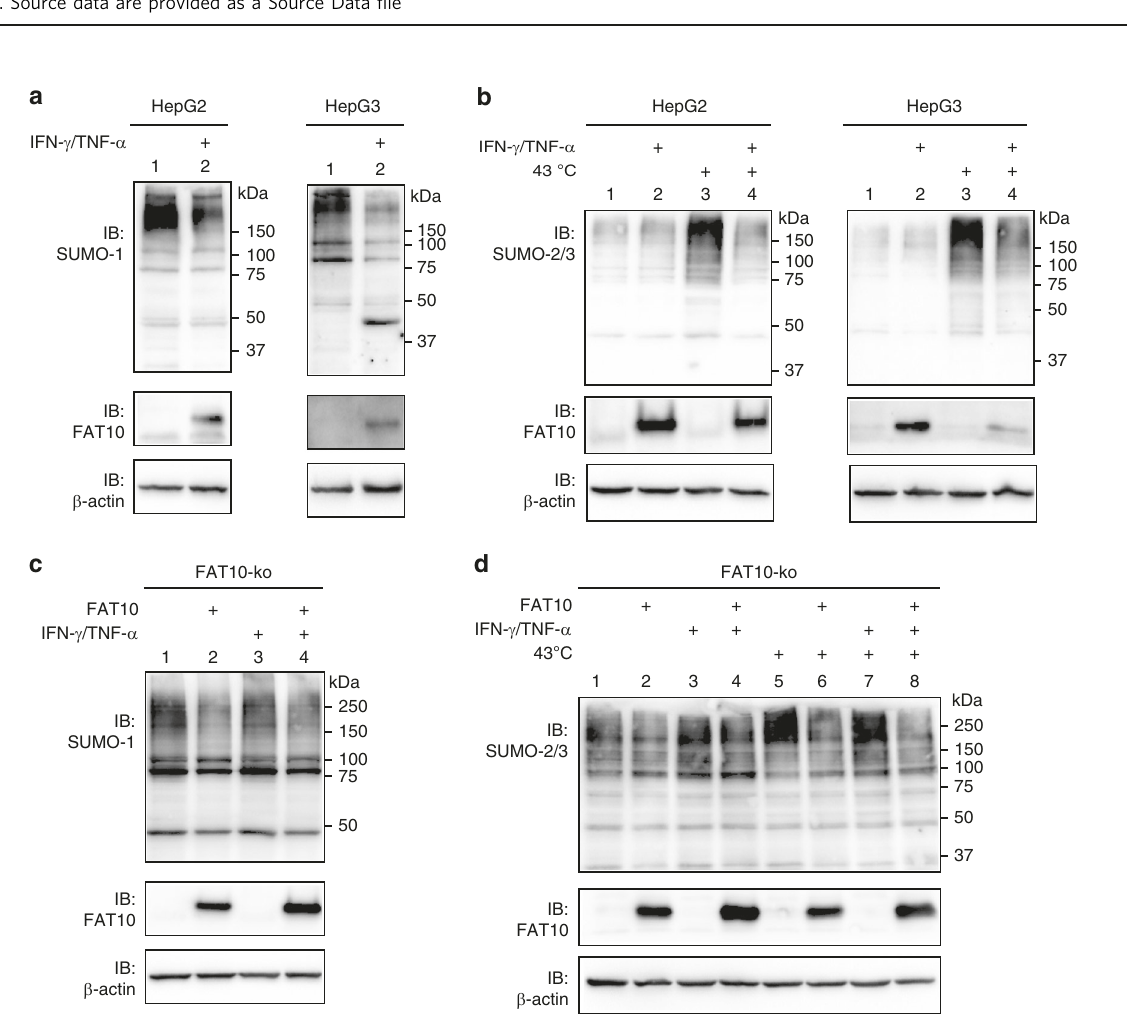
Fig. 4 Endogenous FAT10 inhibits SUMO conjugation. a , b Western blot analyses of SUMO-1 or SUMO-2/3 conjugates in crude cells lysates